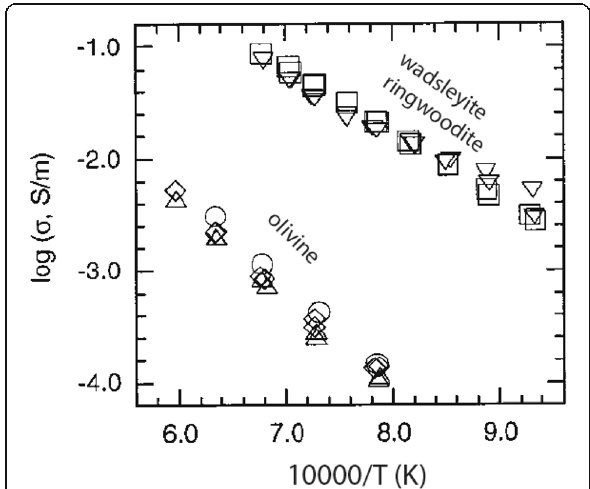
Fig. 3 Electrical conductivity of nominally “ dry ” olivine, wadsleyite, and ringwoodite (from Xu et al. 1998). No water was added, but the FTIR analysis of their samples in my lab showed a substantial amount of water in wadsleyite and ringwoodite. The reported large difference in electrical conductivity is due largely to the difference in water content (Huang et al.